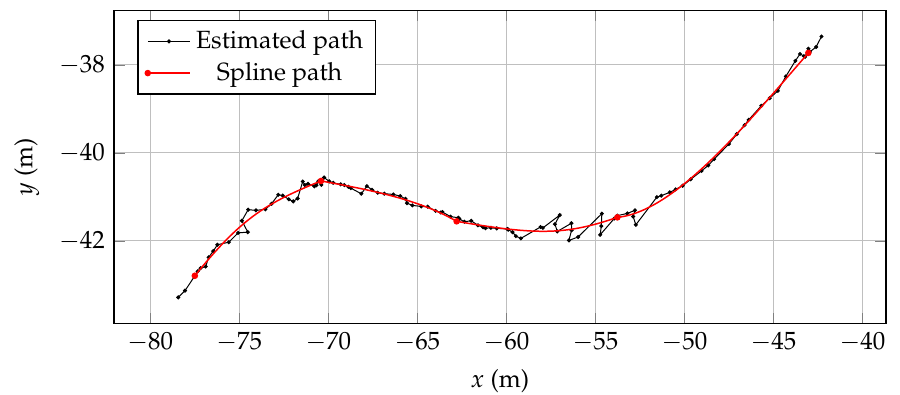
Figure 2. Estimated path from sensor measurements and resulting spline path after applying the spline-approximation